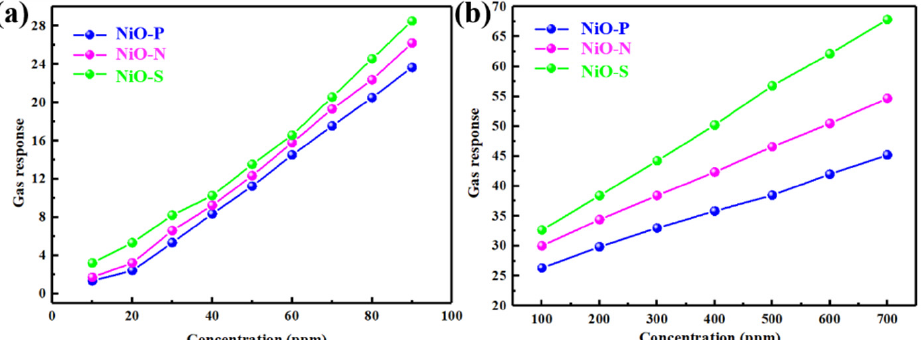
Figure 11. At 350 ◦ C, gas response of NiO as a function of ( a ) the concentration range of 10~90 ppm, ( b ) the concentration range of 100~700 ppm.